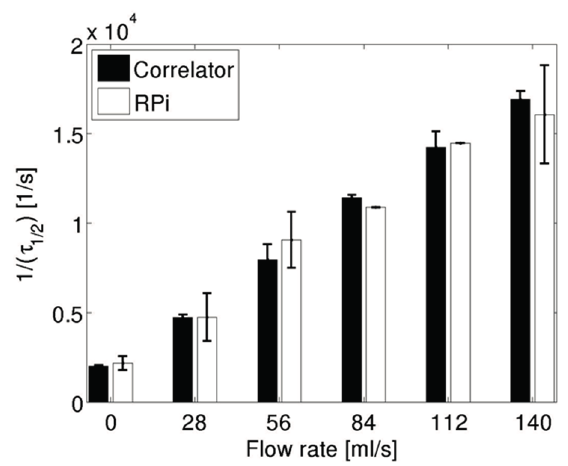
Figure 3. Flow parameter (1/ τ ½ ) for the pump flow experiments using data acquired using the hardware correlator (black bars) and Raspberry Pi (white bars). Bars represent the mean flow parameter across three repeated measurements and error bars are standard